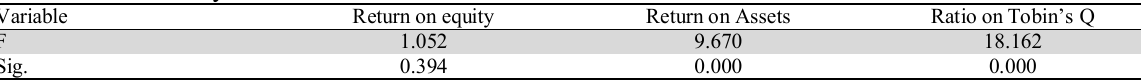
The results of Analysis of